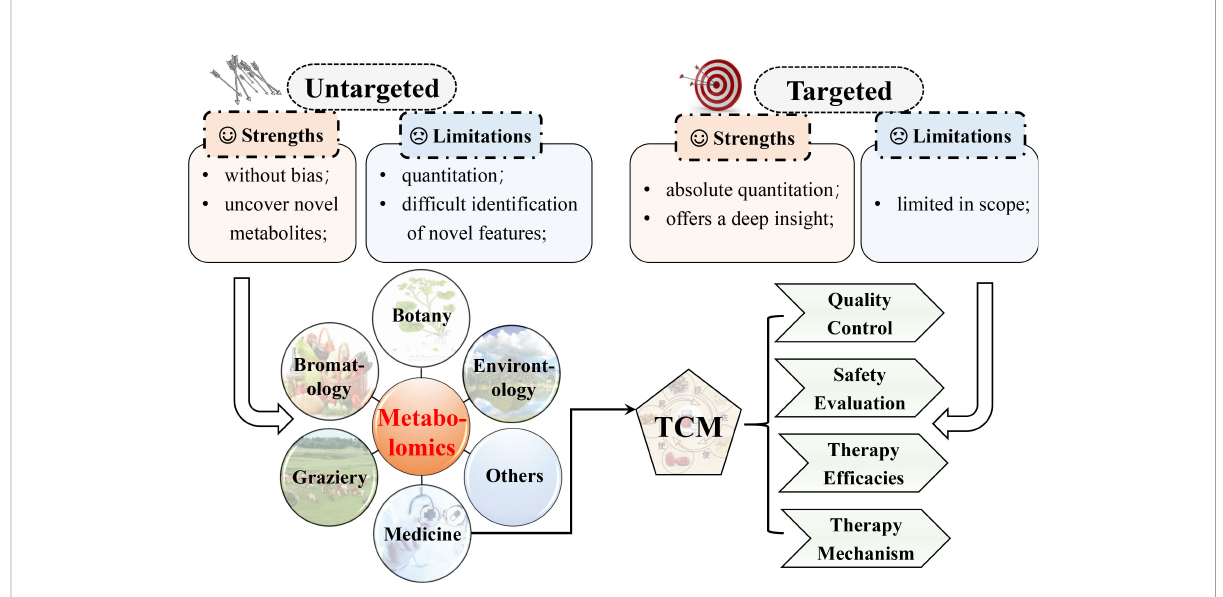
FIGURE 2 Comparison of targeted and untargeted metabolomics and the main applications of metabolomics. Metabolomics has been applied in a spectrum of fi elds.